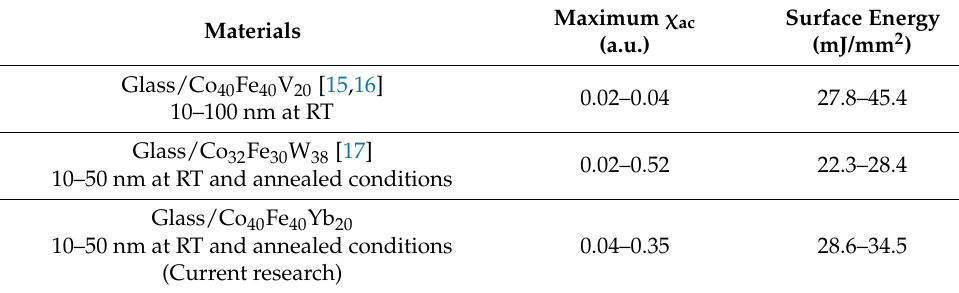
Table 2. Significant properties for CoFeV, CoFeW, and CoFeYb